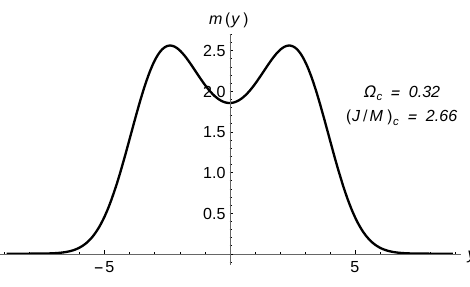
Figure 2 . Pro(cid:12)le along the long axis of the ‘critical’ dumbbell solution with J=M equal to (1.1).